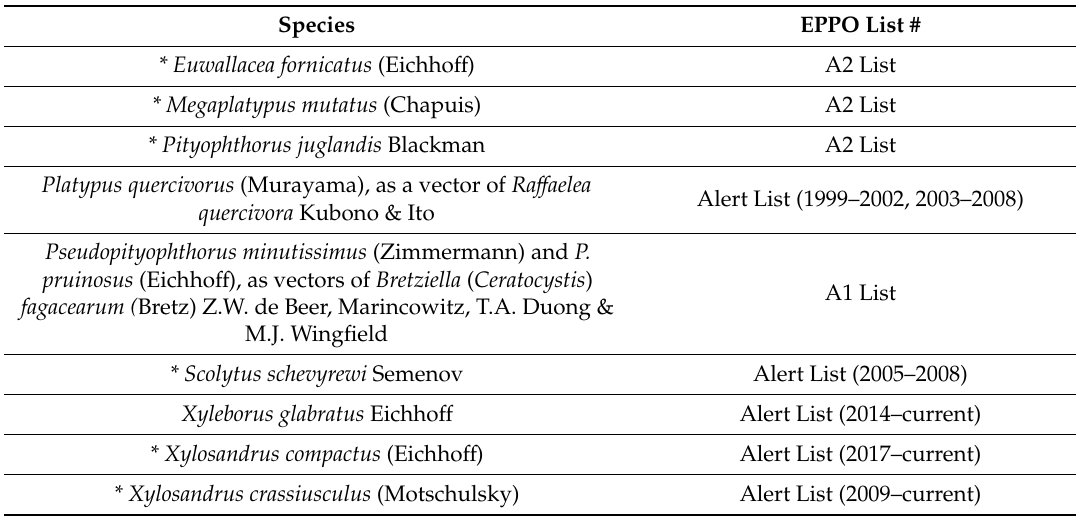
Table 1. Non-coniferous bark and ambrosia beetles on European and Mediterranean Plant Protection Organization (EPPO) lists (as of March